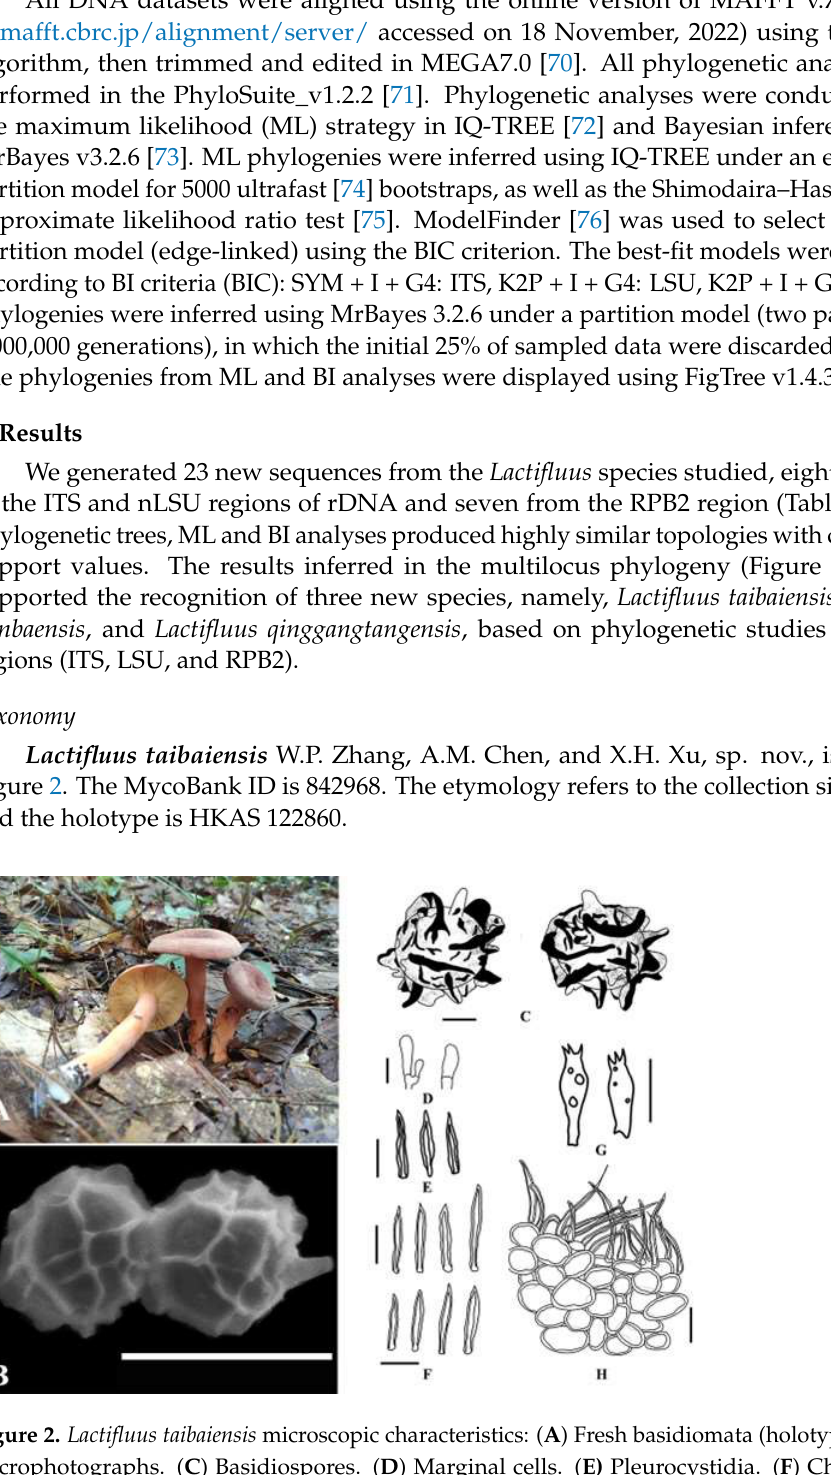
Figure 2. Lactifluus taibaiensis microscopic characteristics: ( A ) Fresh basidiomata (holotype). ( B ) SEM microphotographs. ( C ) Basidiospores. ( D ) Marginal cells. ( E) Pleurocystidia. ( F ) Cheilocystidia. ( G) Basidia. ( H) Pileipellis. Scale bars: 4 µm ( B ), 3 µm ( C ), and 30 µm ( D – H ). Pilei are 35.60–44.50 mm diameter and convex to planoconvex with a broadly de-